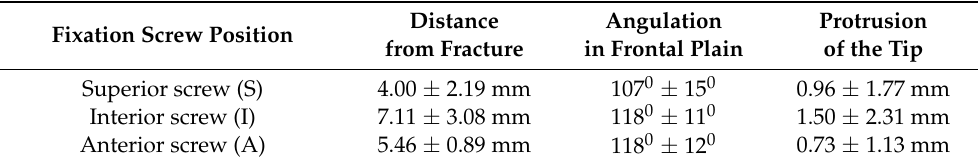
Table 1. Data for fixation screws inserted into the mandibular head.